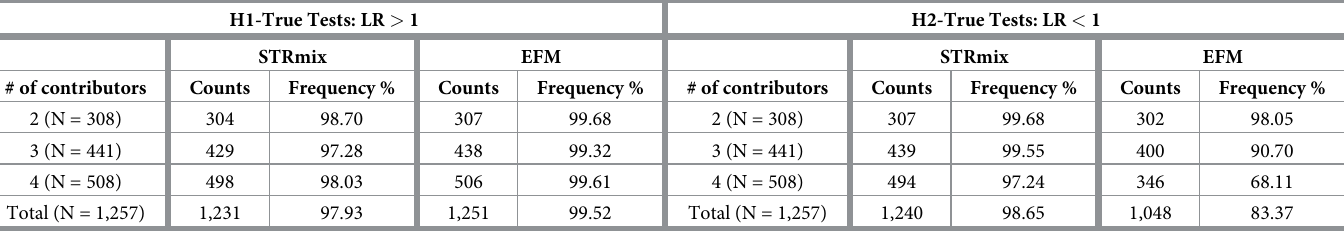
Table 3. Summary of the number of observations and frequency (%) of known contributor analyses (H1-true tests) and known non-contributor analyses (H2-true tests) that yielded log 10 (LR) values > 0 (or LR > 1) and log 10 (LR) values < 0 (or LR < 1), respectively.